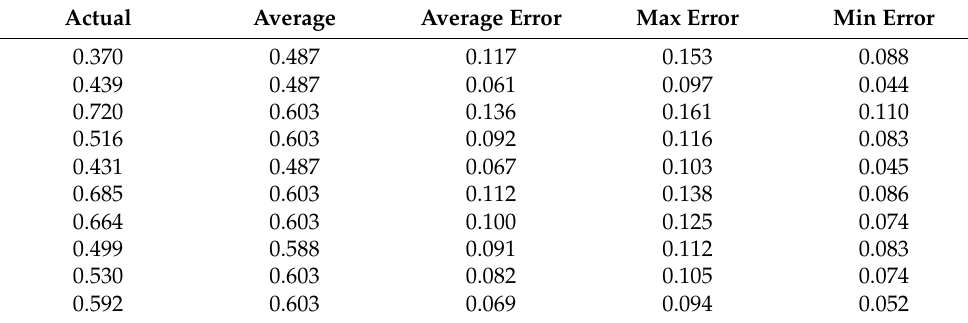
Table A158. Set 3, trials 1–10 data (actual PR value).